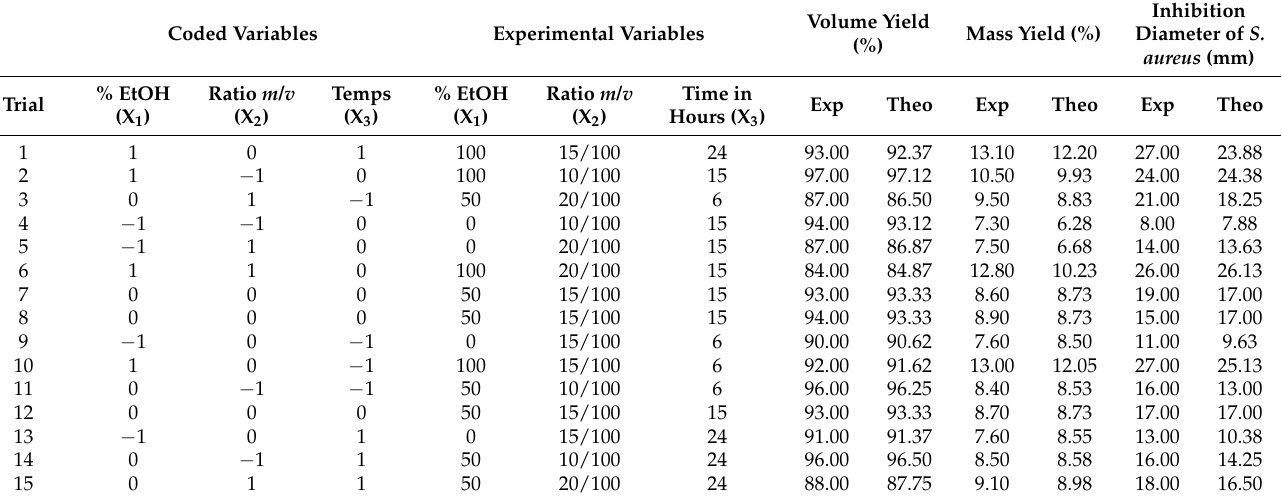
Table 1. Results of the extraction procedure of E. chloranta bark using the Box–Behnken experi- mental